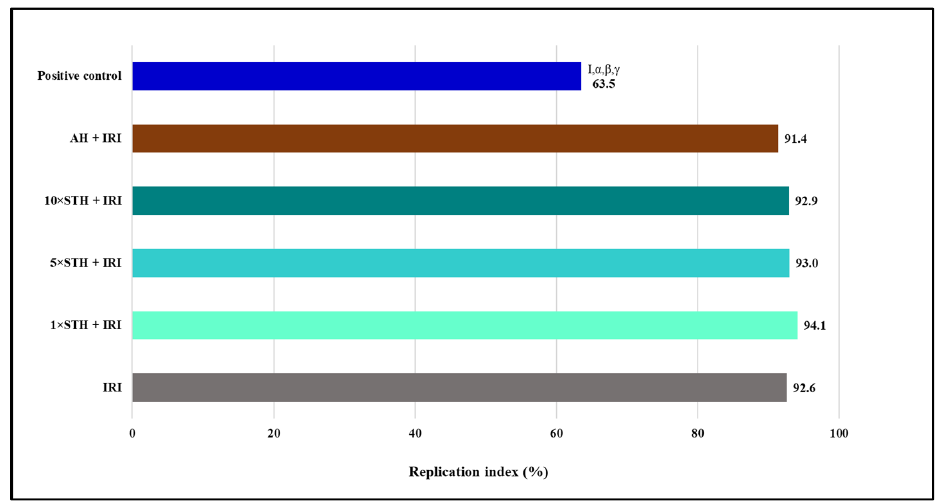
Figure 5. Values of replication index established after treatment with different combinations of the cytotoxic drug irinotecan (IRI) with strawberry tree honey (STH) and artificial honey (AH). Single-IRI-treated cells and positive control (bleomycin—15 mg/L) cells were studied in parallel. Significantly decreased ( p < 0.05) values are I—vs. IRI; α —vs. 1 × STH + IRI sample; β —vs. 5 × STH + IRI sample; γ —vs. 10 × STH + IRI sample.